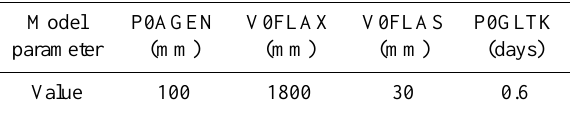
Table 3. Default values for the water allocation and flow-routing parameters of UBC watershed